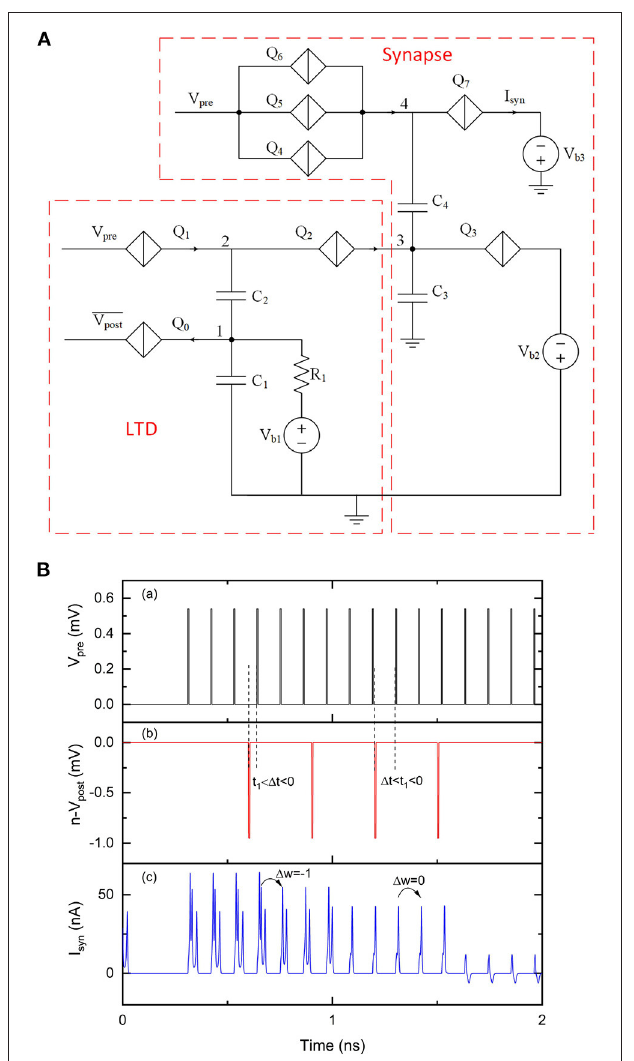
FIGURE 6 | An LTD circuit with a multi-weight synaptic circuit. The number of sequential current pulses at I syn can be reduced when the timings of pulses from V pre and V post trigger an LTD learning event. V pre was 0.54 mV and V post was 0.95 mV. The critical voltage values used for Q 0 – Q 7 were 0.75, 0.55, 0.3, 2, 0.54, 0.52, 0.5, and 0.34 mV, respectively. C 1 and C 3 were 9.2 fF, and C 2 and C 4 were 1.2 fF. V b1 , V b2 and V b3 were 0.03, 0.77, and 0.53 mV, respectively. R 1 was 10 k (cid:127) . (a) Input signal V pre . (A) Circuit schematic. (B) Simulation results. (a) Input signal V pre . (b) Input signal V post . (c) Output signal I syn . FIGURE 7 | An LTP circuit with a multi-weight synaptic circuit. The number of